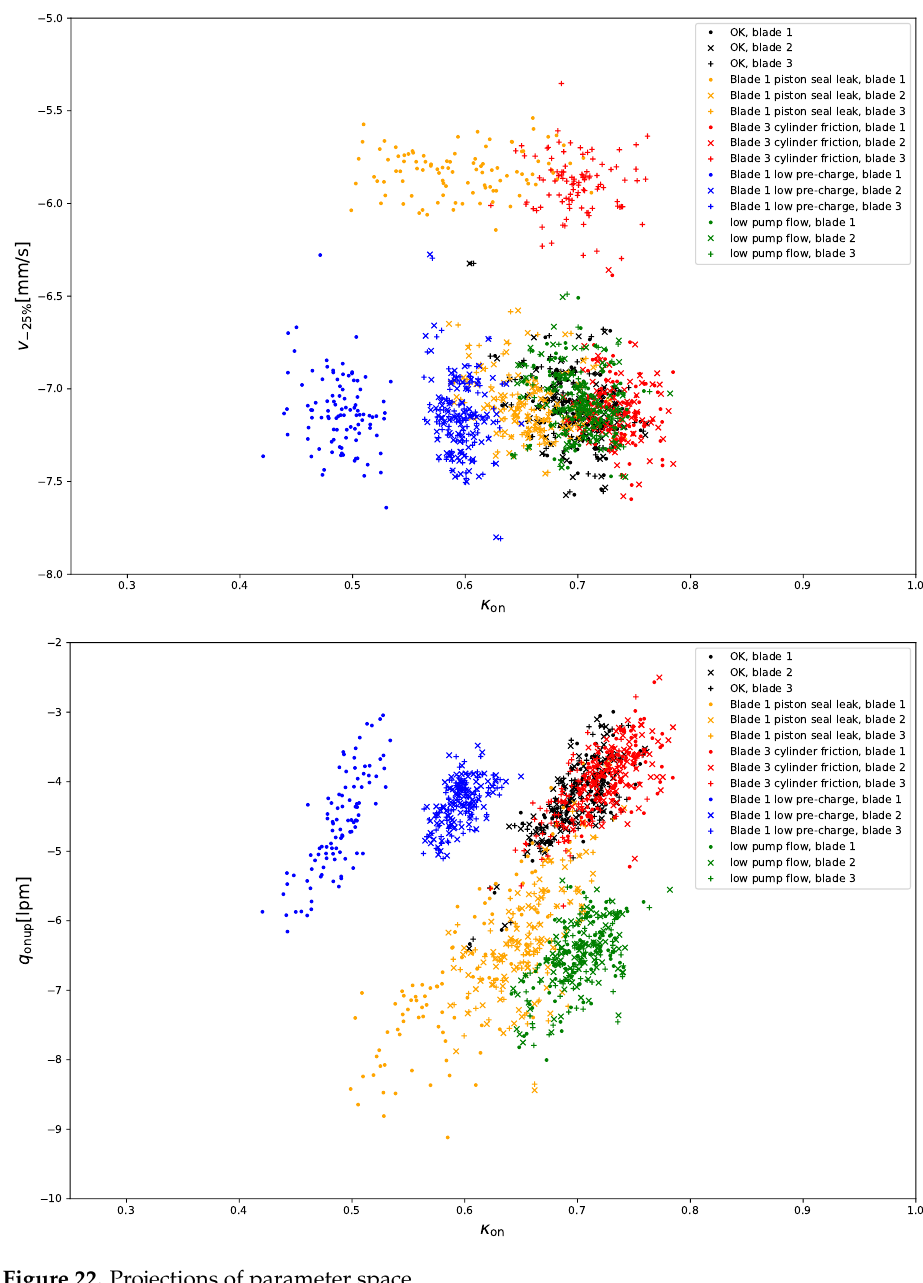
Figure 22. Projections of parameter